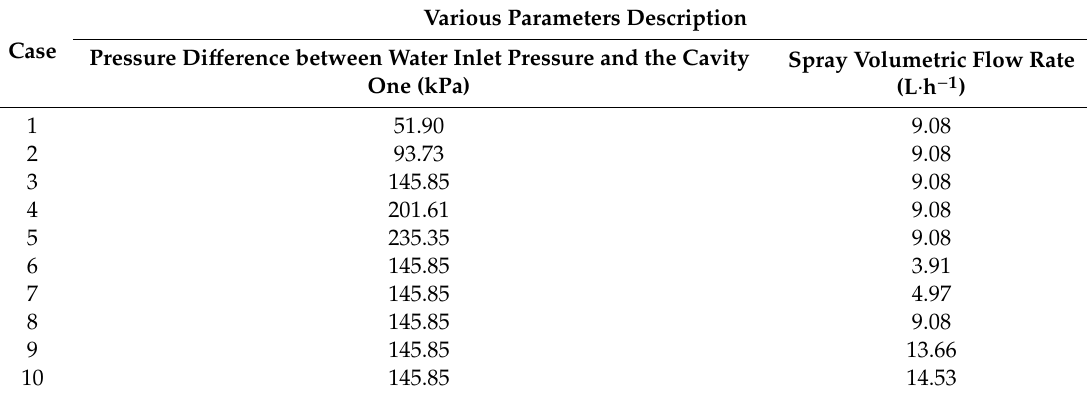
Table 3. Description of experimental operation